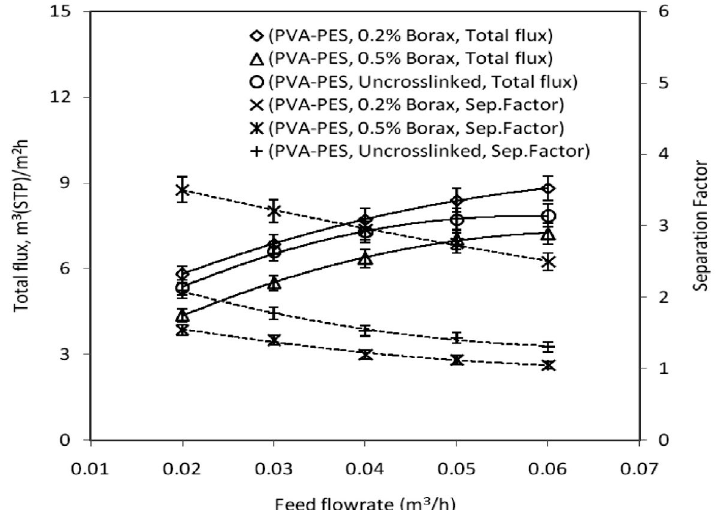
Fig. 9 Total pervaporation flux and separation factor as a function of feed flow rate in the pervaporation of EG-water system (Temperature: 45 °C, Feed concentration: 80% Ethylene glycol by